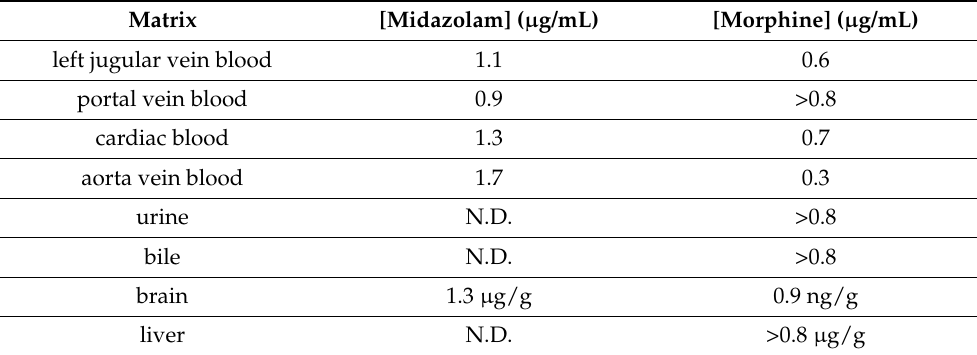
Table 1. Morphine and midazolam concentrations detected in analyzed biological